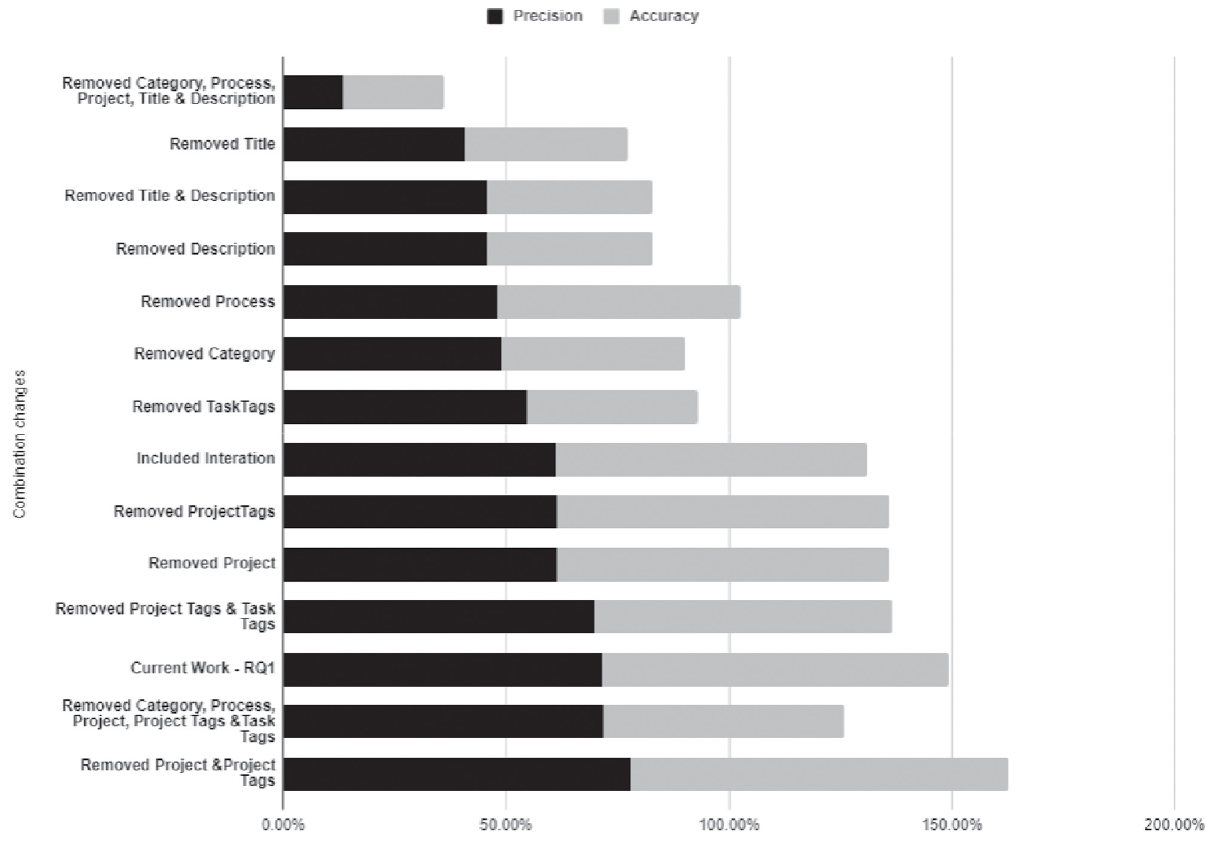
Fig 8. RQ2 results: Context combinations in a graph.